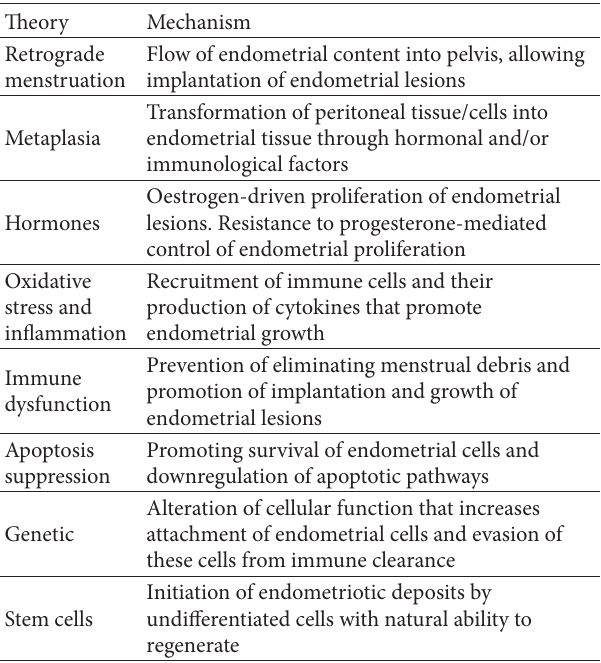
Table 1: Role of the different theories in the pathogenesis of endo-